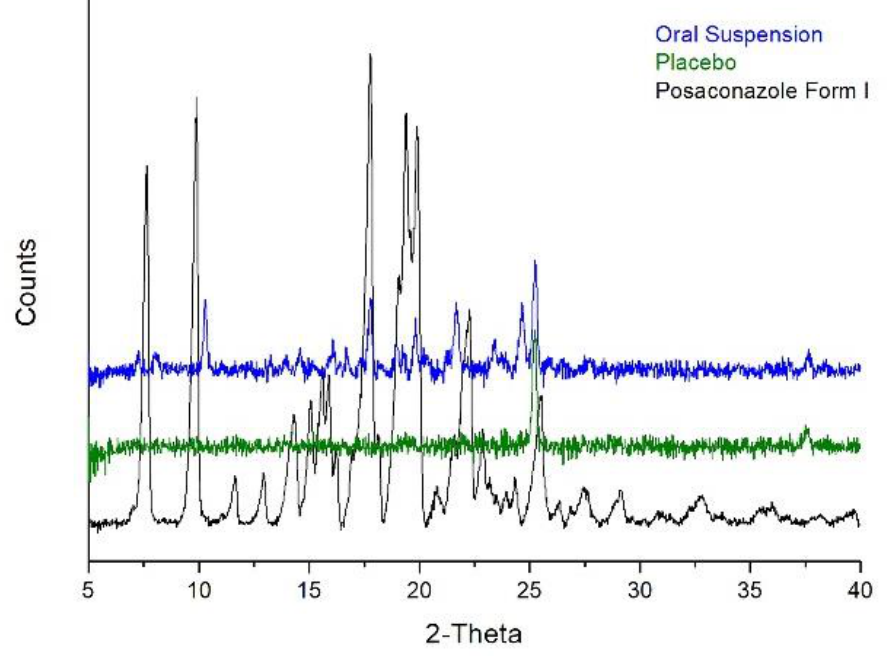
Figure 1. The XRPD patterns of Posaconazole oral suspension ( blue line ), Posaconazole oral suspension ′ s placebo ( green line ) and Posaconazole Form I ( black line ).